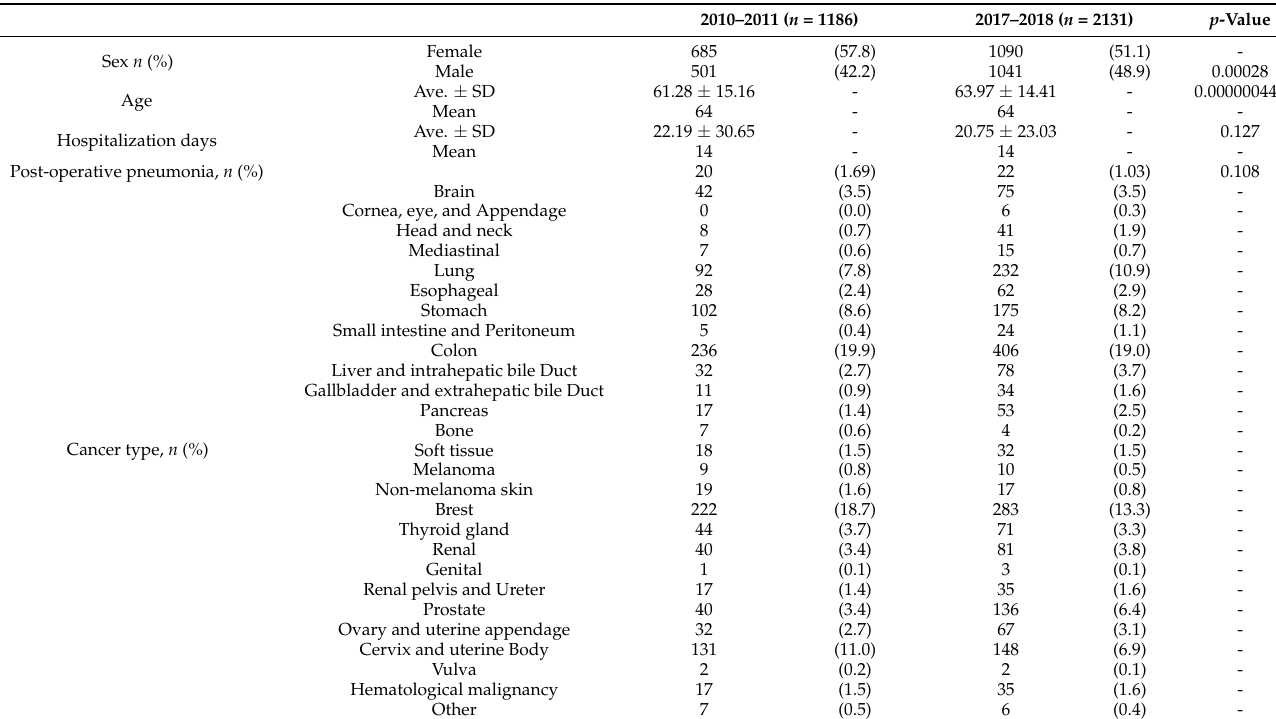
Table 3. Characteristics of the target group.